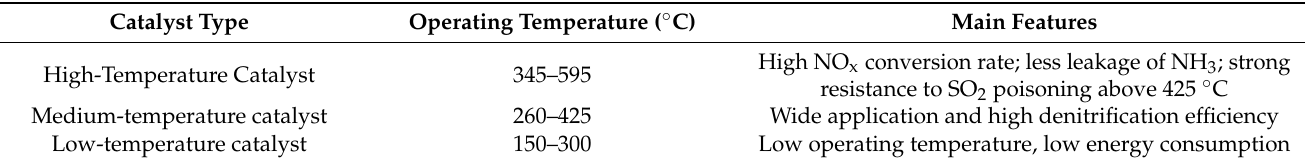
Table 1. Activity characteristics of three types of industrial NH 3 -SCR